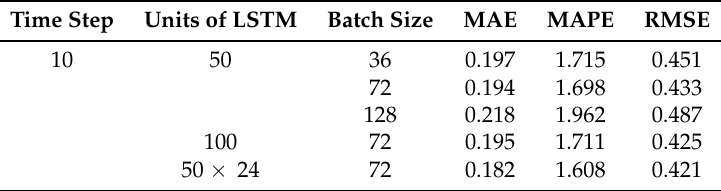
Table 1. Prediction performance with 1-min time